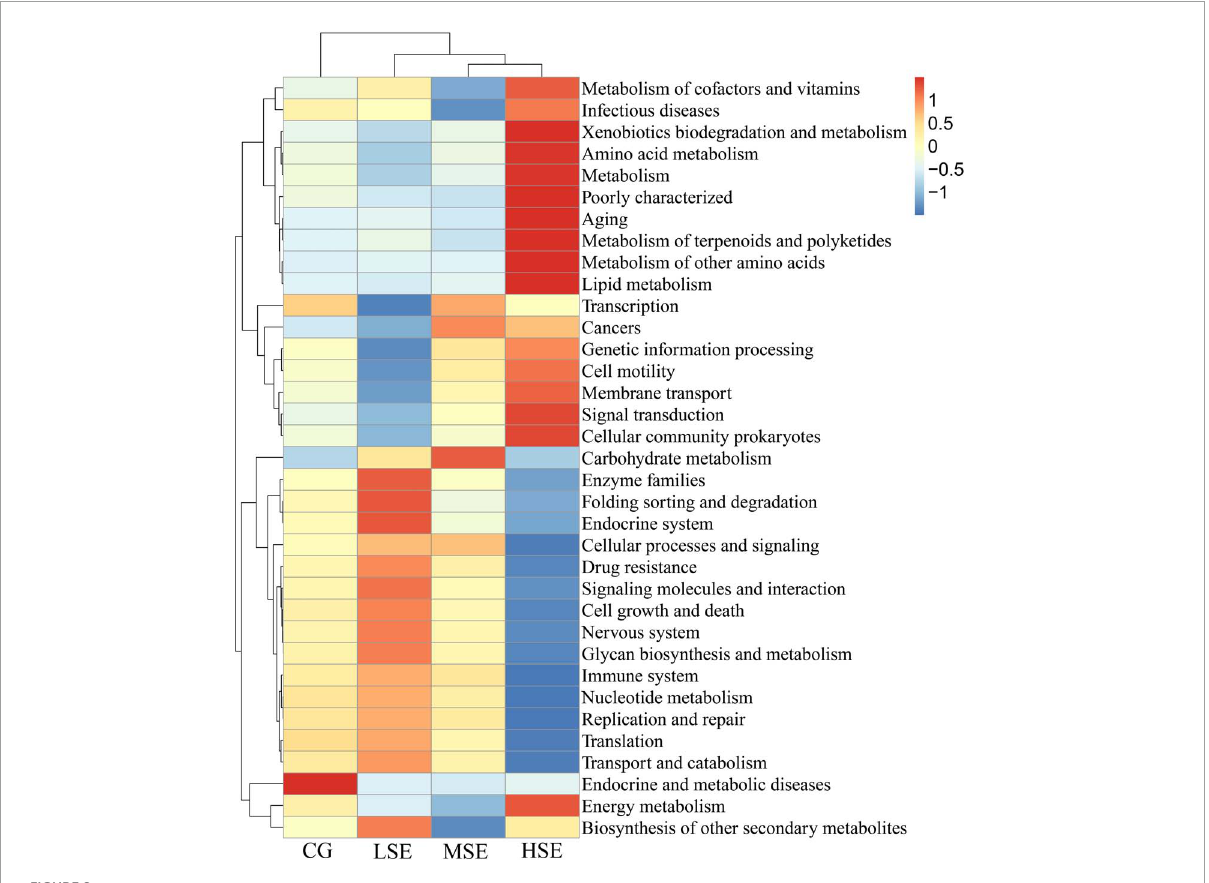
FIGURE8 Heatmap analysis of top 35 predictive functional KEGG pathways as determined by the relative abundance of predictive functional KEGG pathway level 2. The vertical axis is sample information, the horizontal axis is species annotation information. The heatmap in the middle corresponds to the standardized Z-score of the relative abundance of each row functional